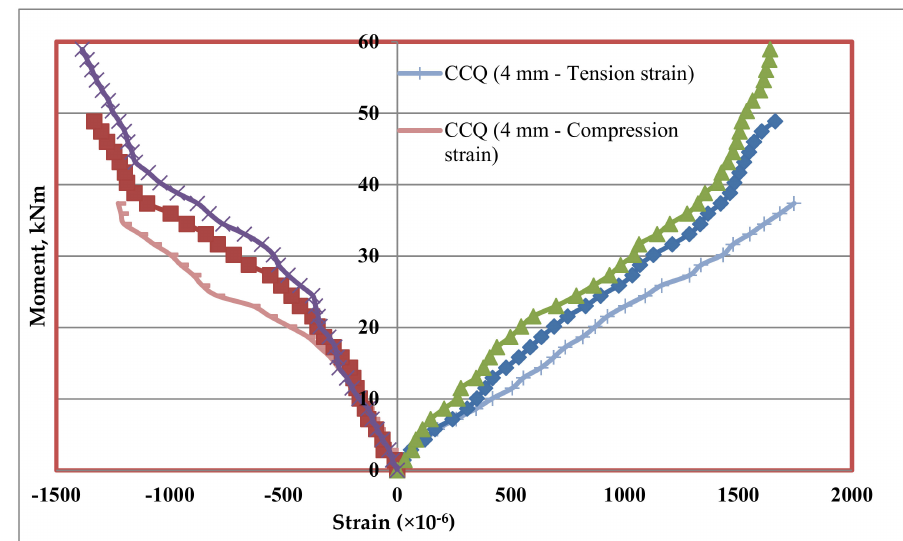
Figure 20. Strain distribution of SCS beams used with CCQ mix.